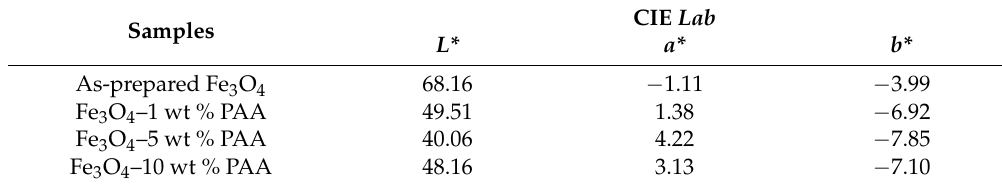
Figure 5. Color parameters for as-prepared Fe 3 O 4 and Fe 3 O 4 modified using 1, 5, and 10 wt % PAA: ( a ) L*; ( b ) a*; ( c ) b*. Table 2. CIE Lab color coordinate data for the as-prepared Fe 3 O 4 and Fe 3 O 4 –PAA.